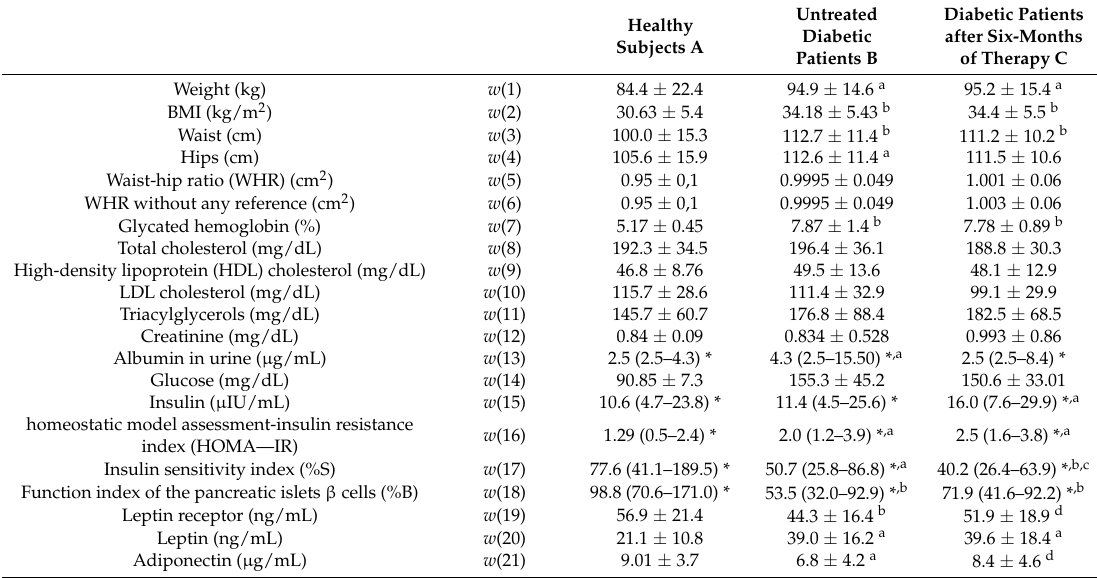
Table 1. Clinical and anthropometric parameters of the healthy subjects and diabetic patients before and after the six-month insulin